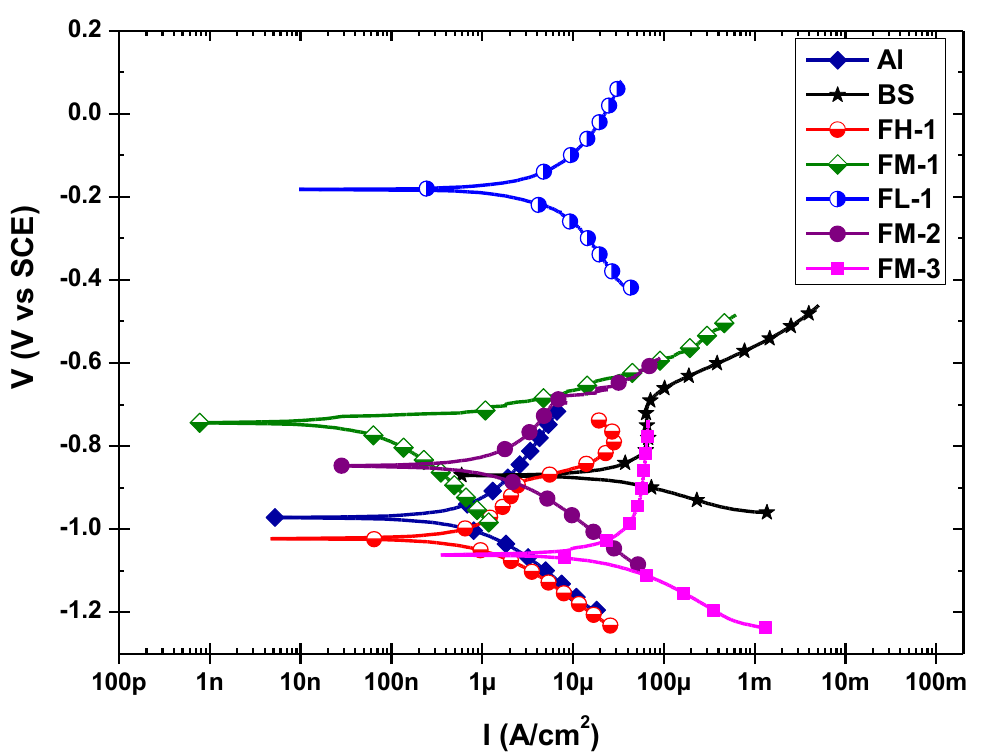
Figure 10. Potential dynamic polarization (PDP) curves showing the effect of rotation speed on the corrosion potential and current density after 21 days of immersion in 3.5% NaCl medium, (Al is the unprocessed Aluminum and BS is the steel base substrate).